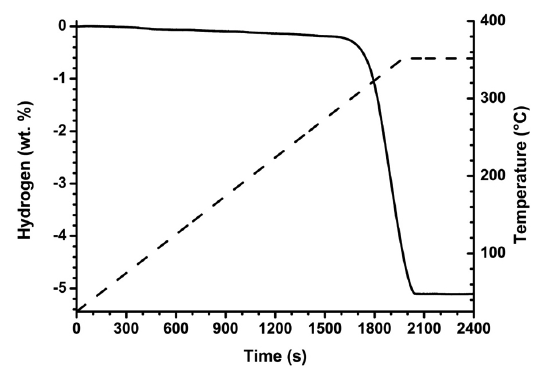
Figure 2. Simultaneous curves of temperature ramp (dash line) and hydrogen desorption kinetic (solid line) under 1 bar of H 2Mg-Fe reactive milled. Heating rate of 10 °C.min –1